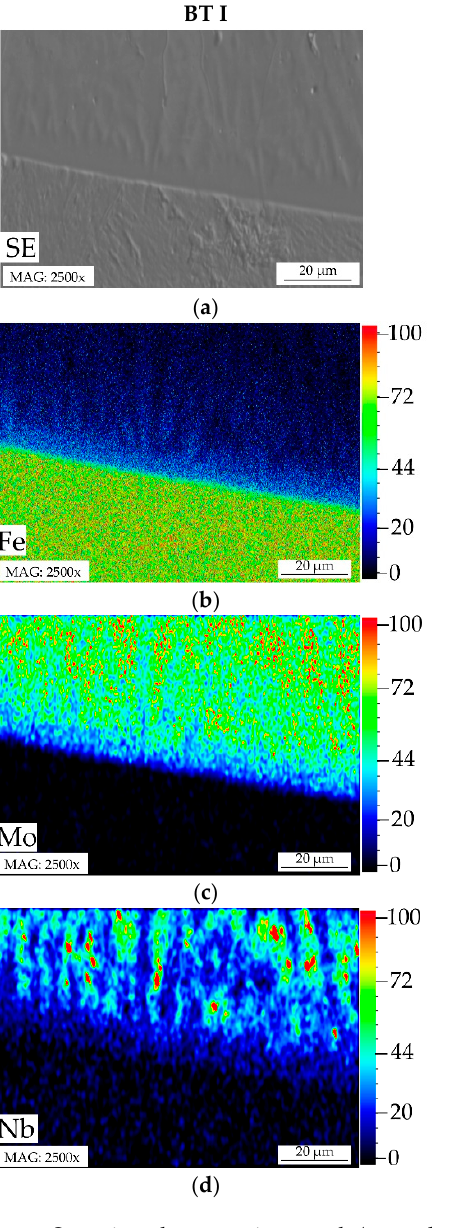
Figure 6. Scanning electron micrograph (secondary electron) of the transition zone of substrate/clad showing grains with boundary type I ( a ) and type II ( e ), variations in the Fe, Mo and Nb contents of these grains with boundary type I (BT I) (( b – d ), respectively) and grains with boundary type II (BT II) (( f – h ), respectively). The magnification of 2500×, the voltage in SEM of 20 kV, scale bar, and work distance of 10.9 mm were the same for all images.